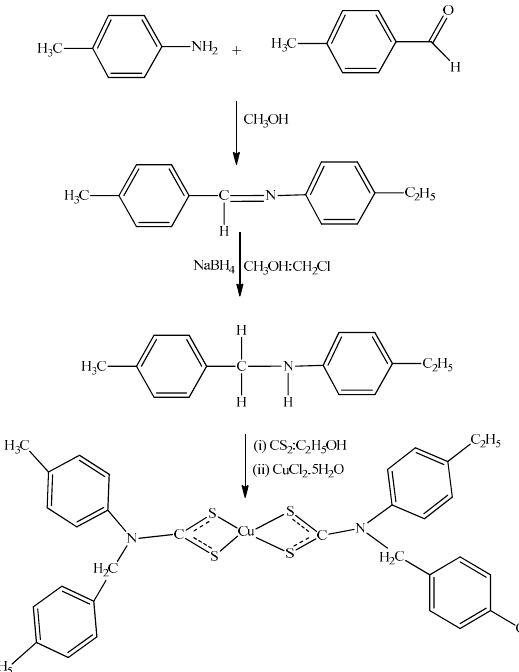
Scheme 1. Preparation of the copper(II) bis( N -4-methylbenzyl)- N -(4-ethylphenyl) dithiocarbamate